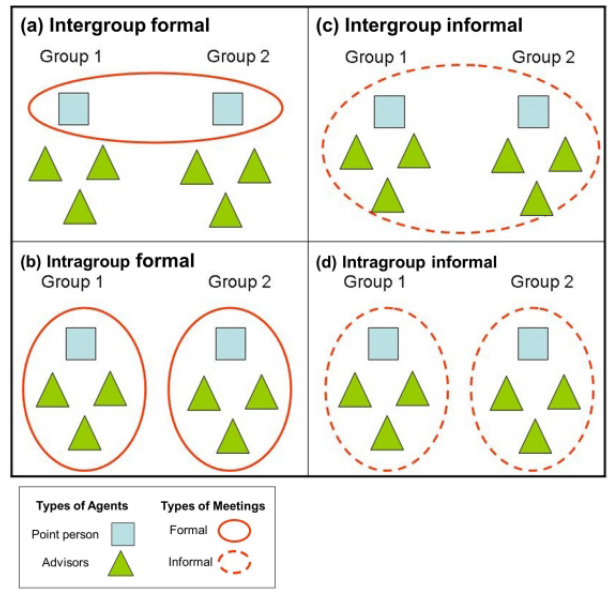
Fig. 2 . Four interaction types: (a) intergroup formal indicates regular meetings only between point persons of each group; (b) intragroup formal indicates regular meetings among all members within their own group; (c) intergroup informal indicates casual exchanges among all members of different groups; and (d) intragroup informal indicates casual interactions of all members within their own